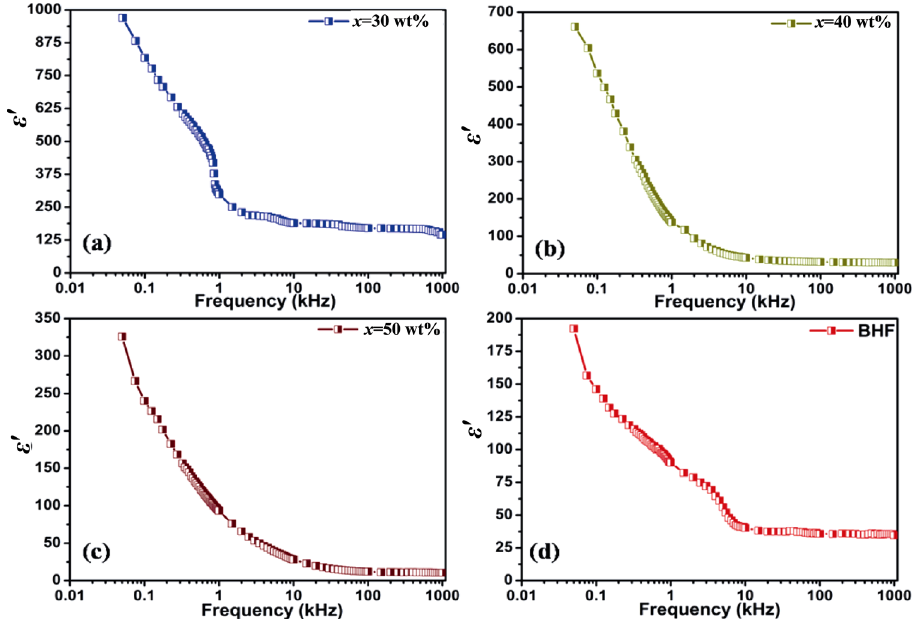
Fig. 5 Frequency dependence of dielectric constant ( ε′ ) for (1 ̶ x )KNN–( x )BHF composites: (a) x = 30 wt%, (b) x = 40 wt%, (c) x = 50 wt%, and (d)